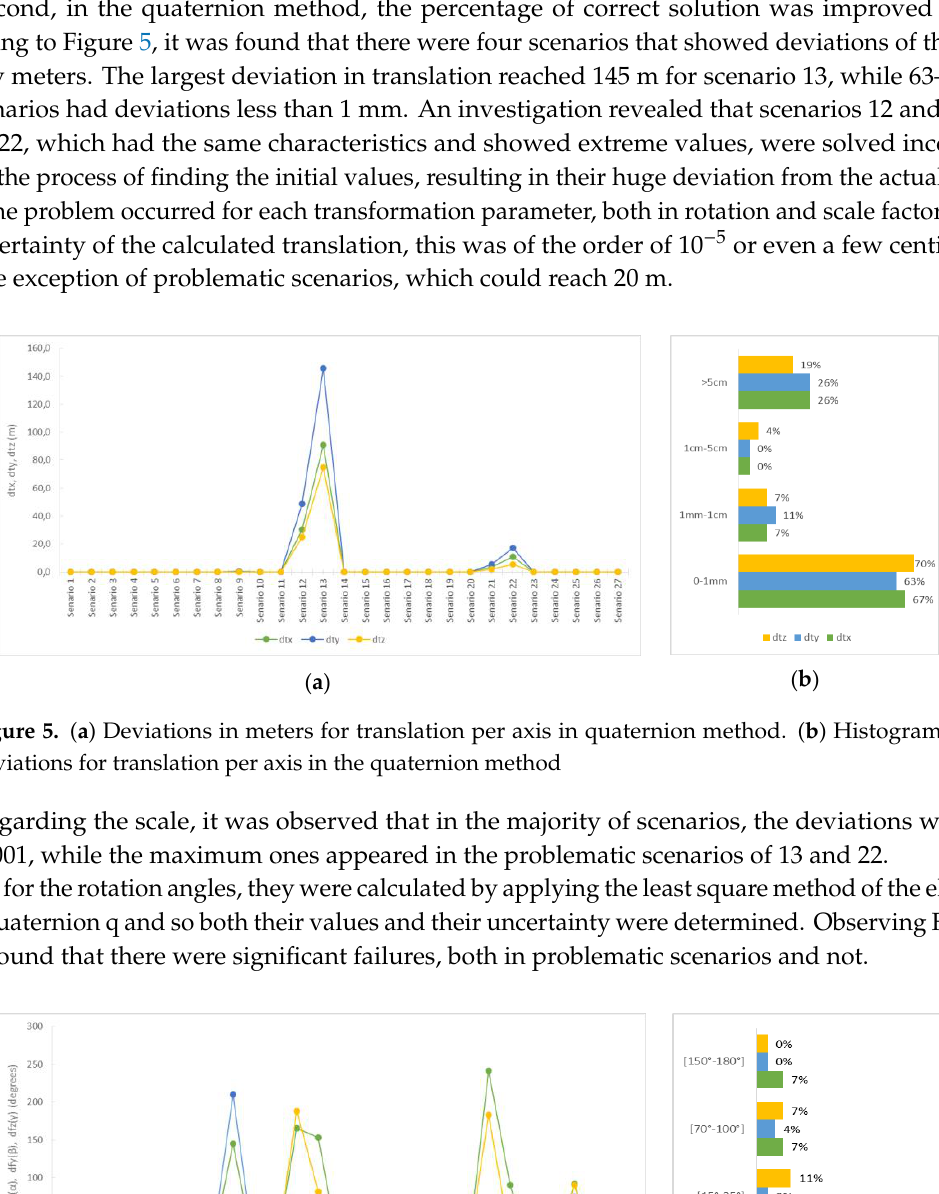
Figure 6. ( a ) Deviations in degrees for rotation angles per axis in the quaternion method. ( b ) Histogram of deviations for rotation angles per axis in the quaternion method.